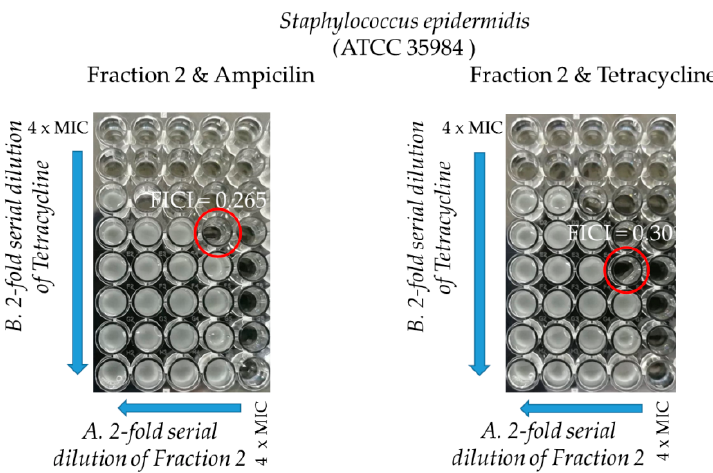
Figure 7. Effect of the combination of fraction F2 with antibiotics: ampicillin (left) and tetracycline (right) against certified S. epidermidis ATCC 35984. FICI arrows indicate the direction of the decreasing concentration. Fraction F2 MIC = 9.3 μ g/mL.